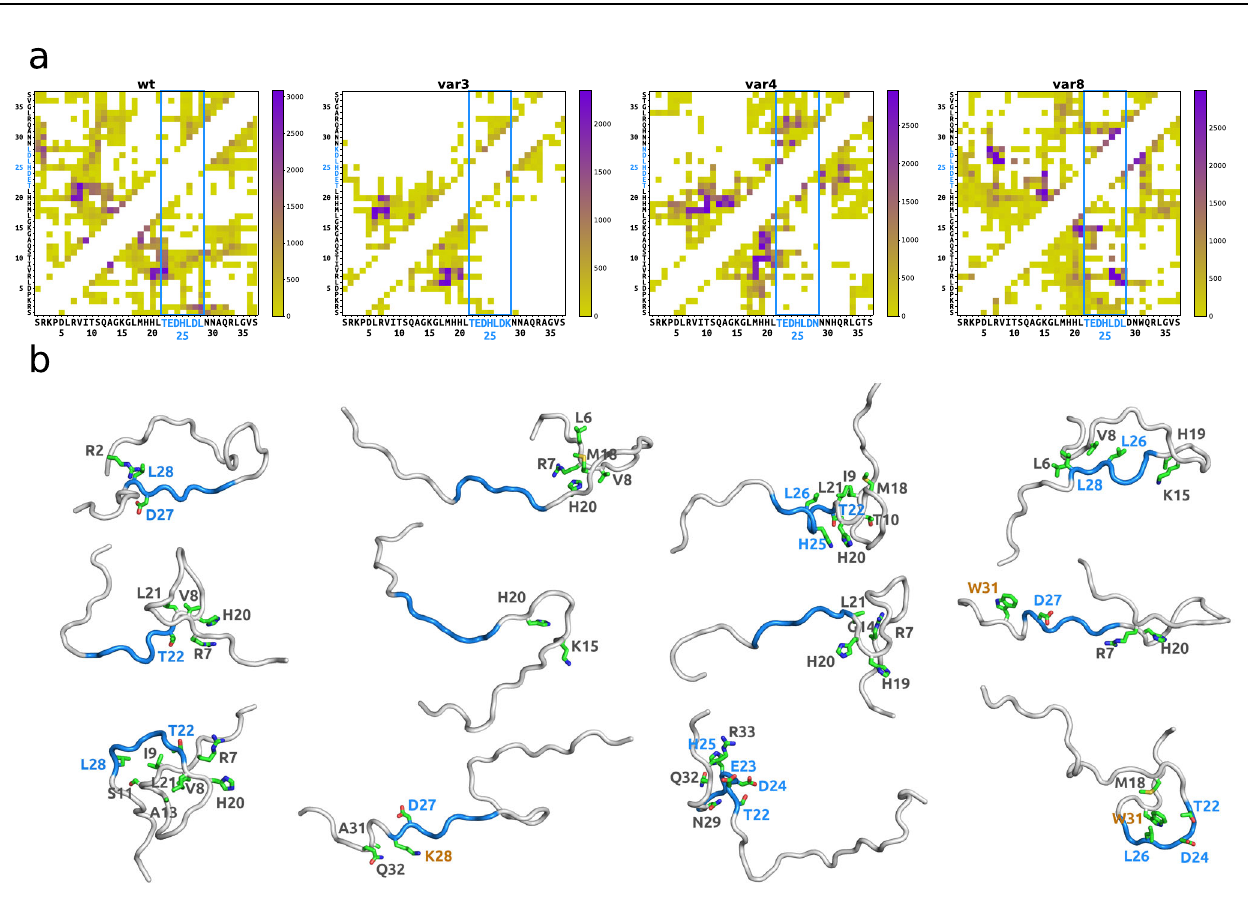
Fig. 4 | Mef2D forms liquid-like and solid-like higher order assembly. a Mef2D fociinthenucleusandcytoplasm.SubcellulardistributionofMef2D wt , var3 , var4 and var8 in C2C12 cells grown in cycling or differentiating medium exhibit foci formation in both the nucleus and cytoplasm. Higher-order assembly is most pronouncedincaseof var8 withrigid β -domain,butisalsoobservedincaseof var3 and var4 with mobile β -domain. 24 hrs post-transfection cells were fi xed and stained with an antibody speci fi c for Mef2D. Nucleic acid was stained using DAPI. The scale bar is 10 μ m on the representative images. The experiment was per- formed four times (cycling medium) and three times (differentiating medium). Quanti fi cation is shown in panel b . b Quanti fi cation of MEF2D cells with cyto- plasmic higher-order structures (foci). The percentage of Mef2D overexpressing cellswithcytoplasmicaggregatesissigni fi cantlyhigherincaseof var8 withrigid β - domain. Cycling C2C12 cells: n =4,±s.e.m.; differentiating C2C12 cells: n =3